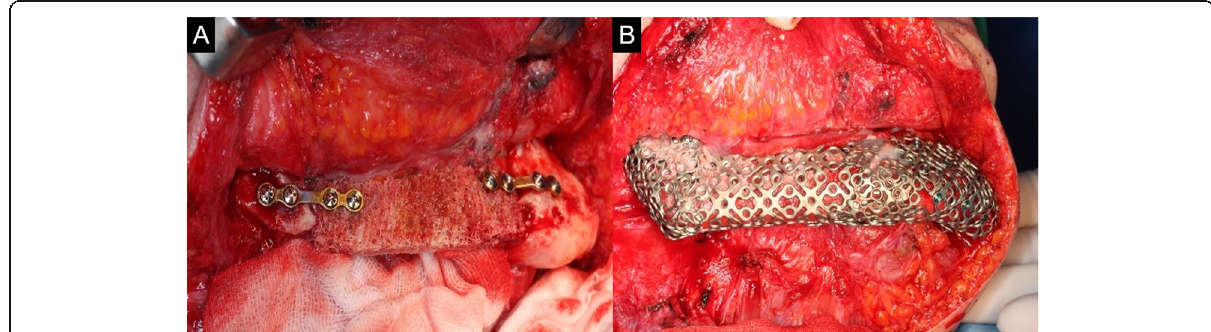
Fig. 6 a. Intraoperative mandible with iliac block, PCBM b . Intraoperative mandible with custom-made type